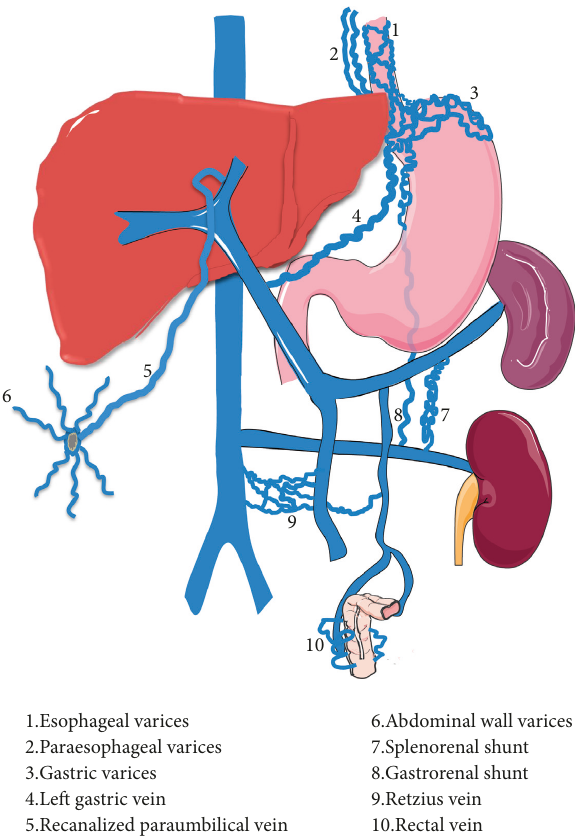
Figure 1: A schematic diagram of spontaneous portosystemic shunt in liver cirrhosis. Note: (1) esophageal varices; (2) para- esophageal varices; (3) gastric varices; (4) left gastric vein; (5) recanalized paraumbilical vein; (6) abdominal wall varices; (7) splenorenal shunt; (8) gastrorenal shunt; (9) Retzius vein; (10) rectal